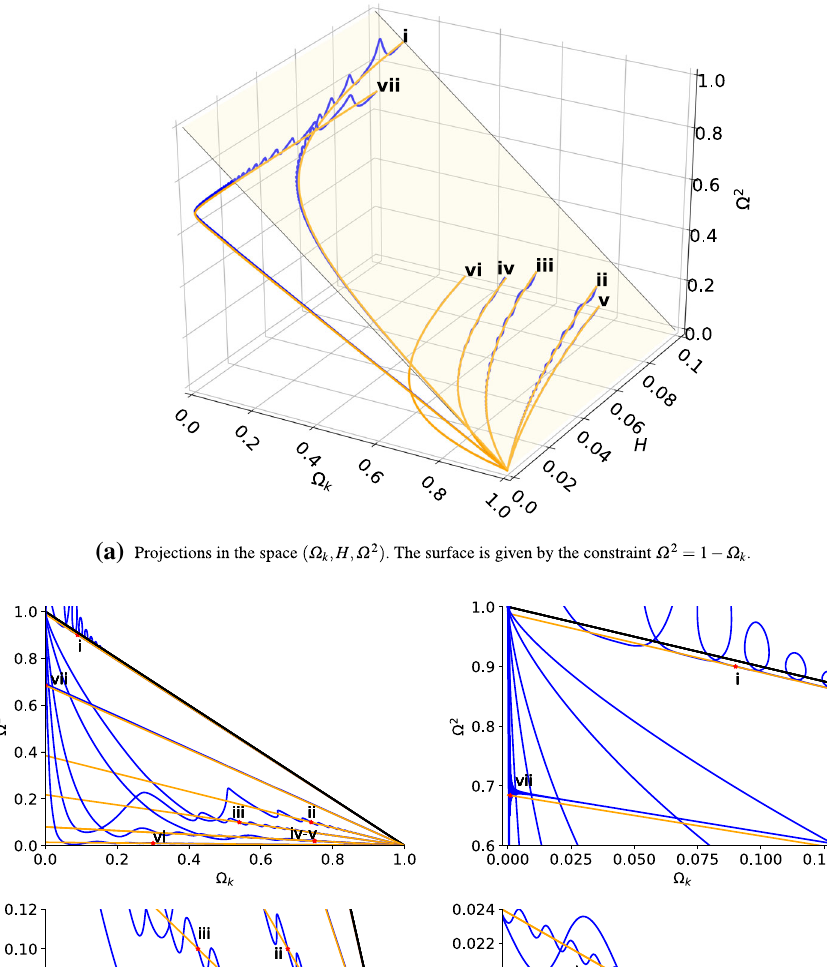
Fig. 22 Some solutions of the full system (71) (blue) and time-averaged system (107) (orange) for the FLRW metric with negative curvature ( k = − 1) when γ = 1. We have used for both systems initial data sets presented in the Table